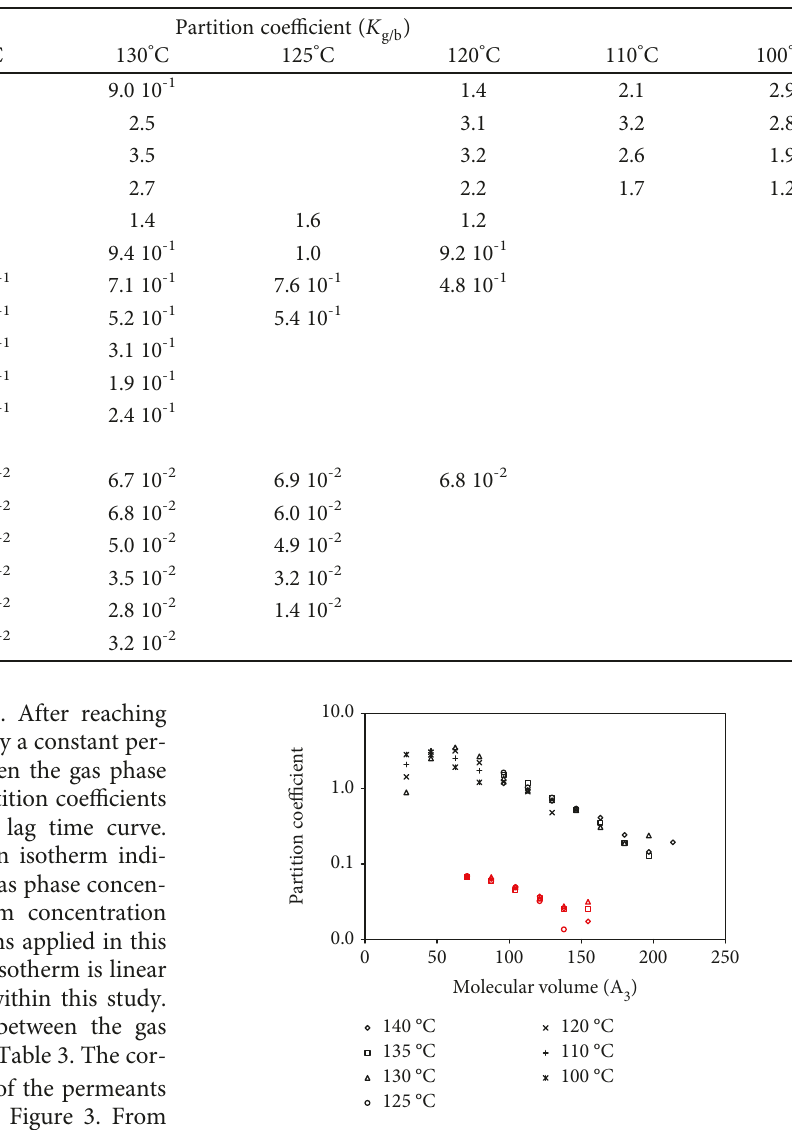
Figure 3: Correlation between the molecular volume of the permeants and the partition coe ffi cients K red dots: